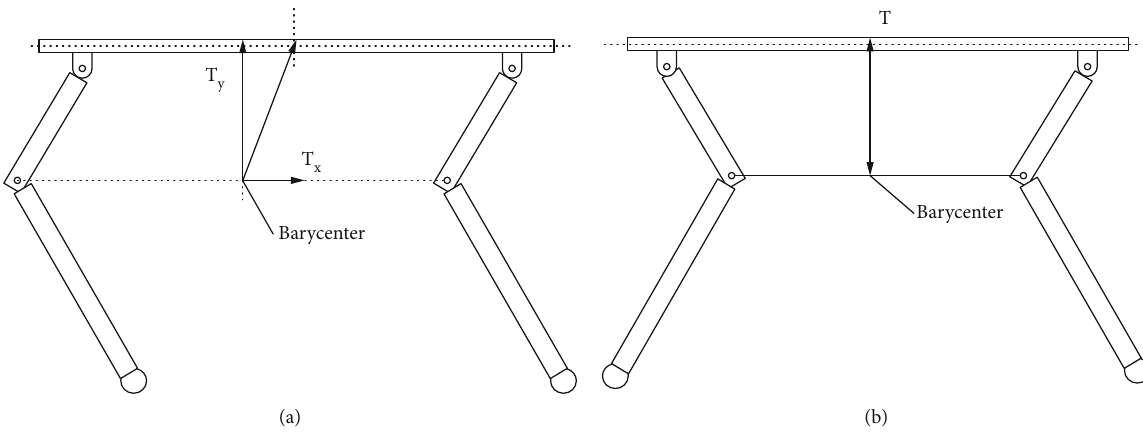
Figure 13: Schematic diagram of torque analysis in quadruped robots with (a) full elbow joint and (b) elbow joint for front legs and knee joint for back legs.